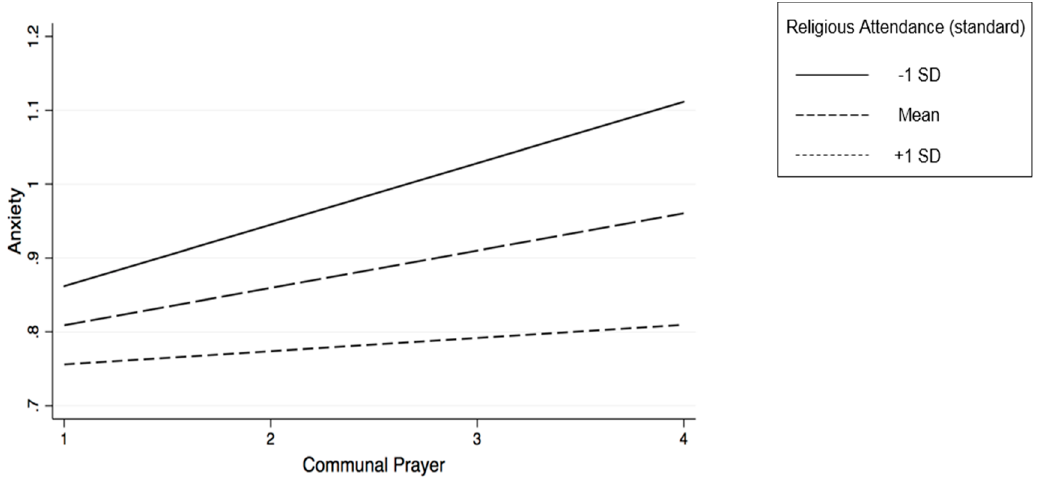
Figure 1. Communal Prayer x Religious Attendance on Symptoms of Anxiety.